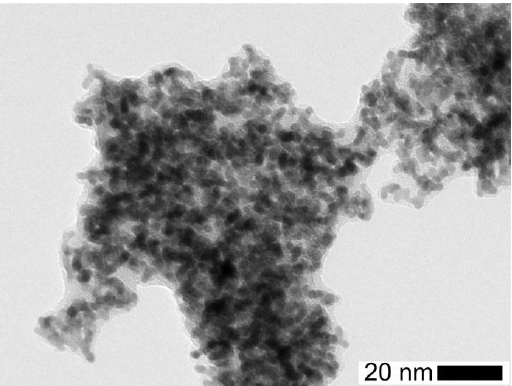
Figure 11. TEM micrograph of a coated Pt agglomerate after a reaction time of 185 s with a TEOS concentration of 0.7 ppmv showing a thick coating.